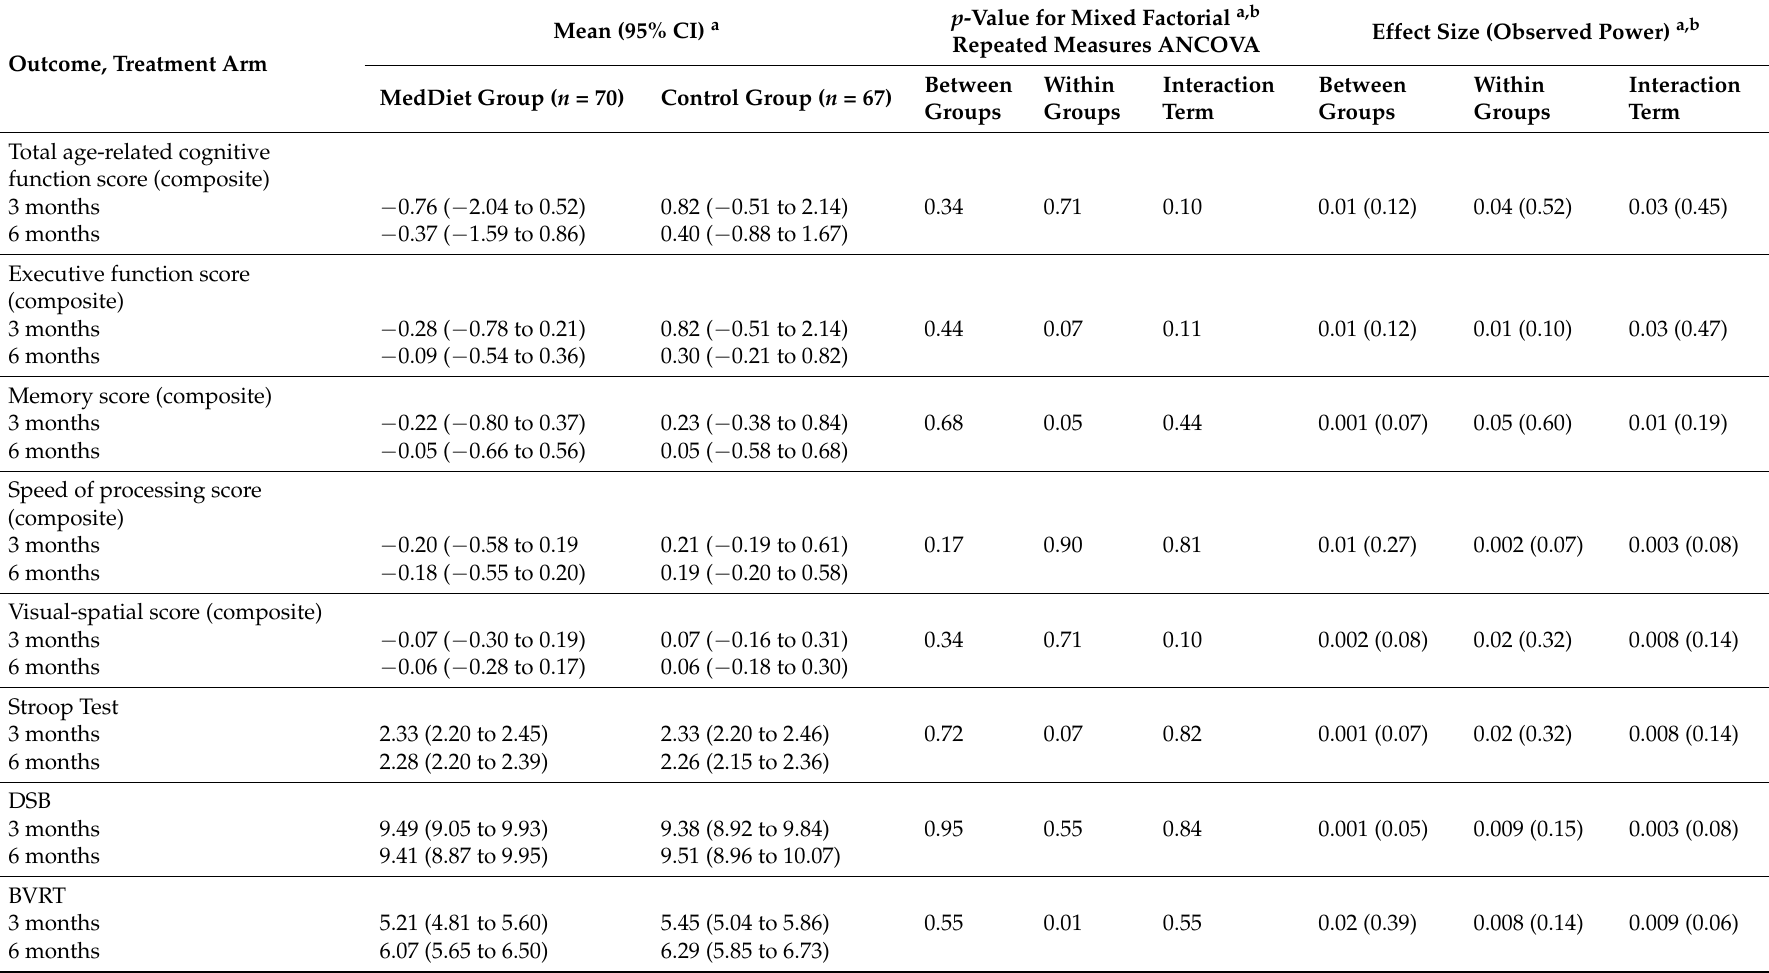
Table 5. MedDiet group versus control group on age-related cognitive performance outcomes after 6 month follow-up, interaction effects. Mean (95% CI) a Outcome, Treatment Arm MedDiet Group ( n = 70) Control Group ( n = 67)